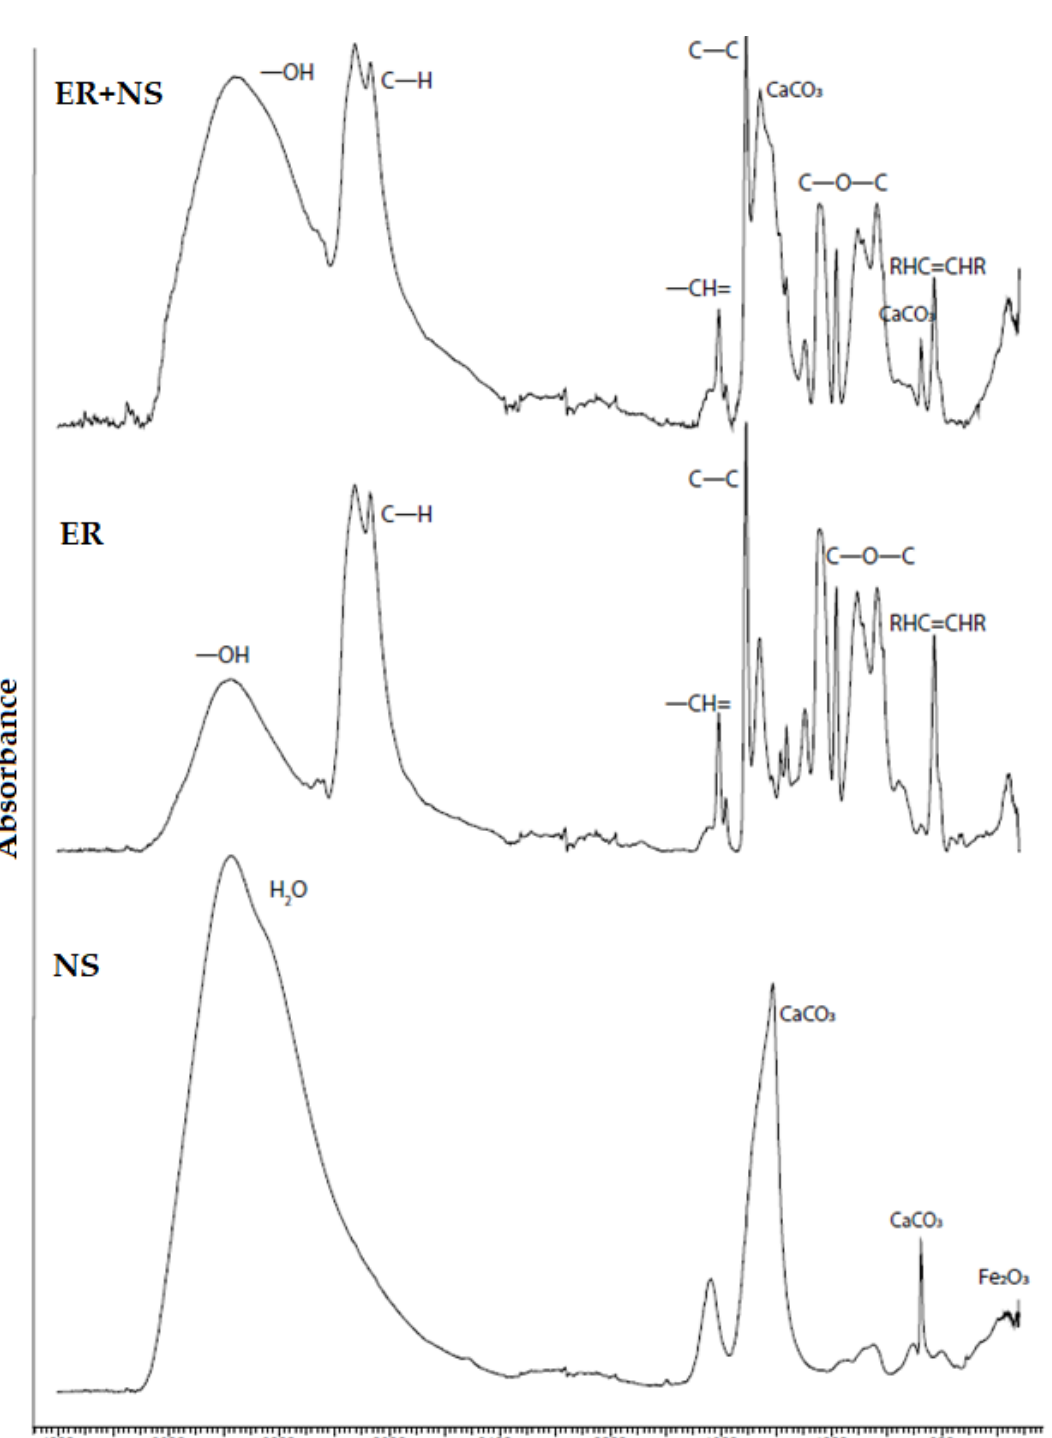
Figure 20. FTIR analysis—comparison of spectrums of neutralisation sludge (NS) with epoxy resin, pure epoxy resin (ER) and NS.